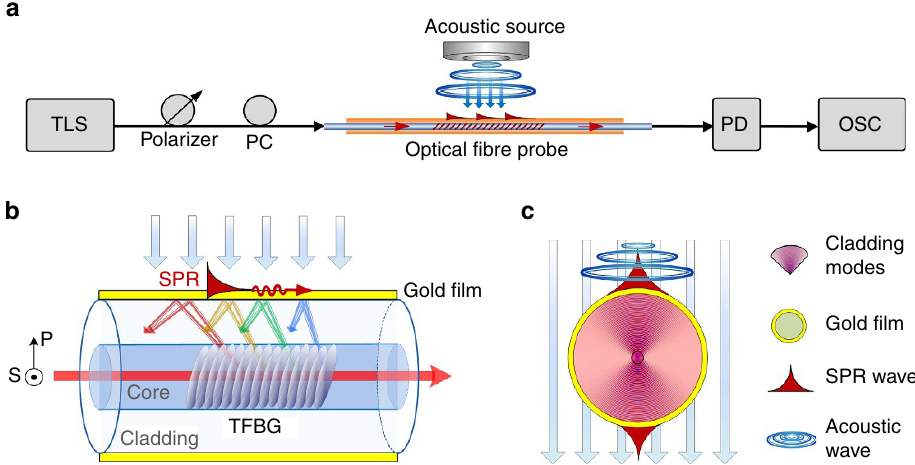
Figure 9 | Acoustic wave-sensing principle with gold-coated highly tilted FBGs. ( a ) The experimental setup used to interrogate the sensor. OSC, oscilloscope; PC, polarization controller; PD, photodiode; TLS, tunable laser source. ( b ) SPR excitation mechanism with gold-coated highly tilted FBGs. S and P indicate the polarization direction relative to the fibre. ( c ) Acoustic wave influence of the SPR wave.